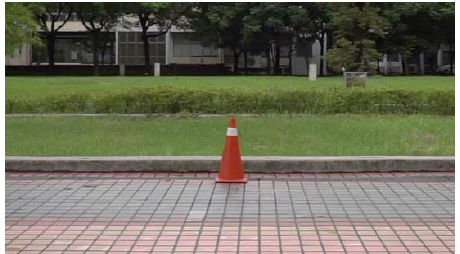
Figure 6. Cropped Photo Containing a Traffic Cone (Taken from the Left